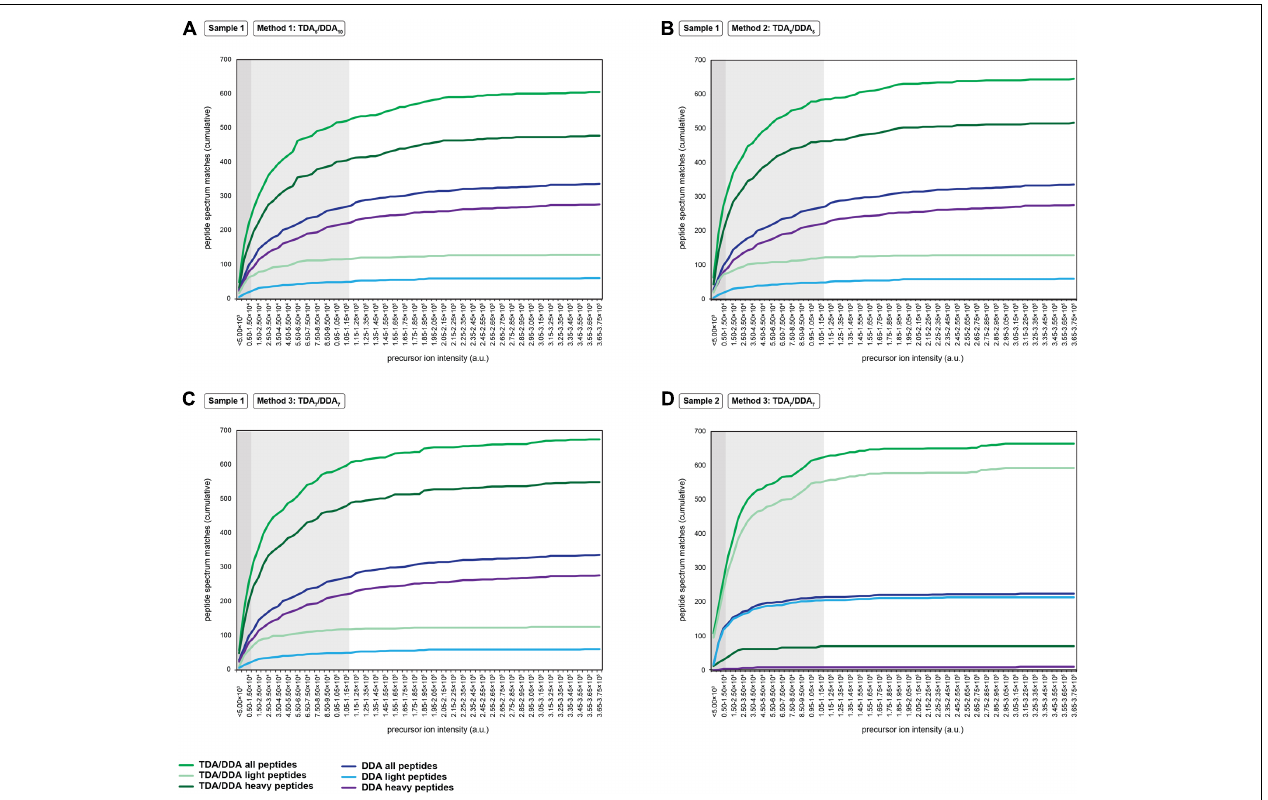
FIGURE 4 | Cumulative precursor ion intensity distributions for peptide spectrum matches derived from the miRNA target proteins of Table 1 . (A) Data from TDA 5 /DDA 10 (method 1) experiments conducted on sample 1. (B) Data from TDA 5 /DDA 5 (method 2) experiments conducted on sample 1. (C) Data from TDA 7 /DDA 7 (method 3) experiments conducted on sample 1. (D) Data from TDA 7 /DDA 7 (method 3) experiments conducted on sample 2. Panels (A–C) include data from DDA control method experiments conducted on sample 1, and panel D includes data from DDA control method experiments conducted on sample 2. All data are from combined sets of technical replicate TDA/DDA and DDA control method experiments. Moderate and low precursor ion intensities (respectively, defined as < 1.50 × 10 4 a.u. and < 1.15 × 10 5 a.u.) are highlighted in light gray and dark gray,